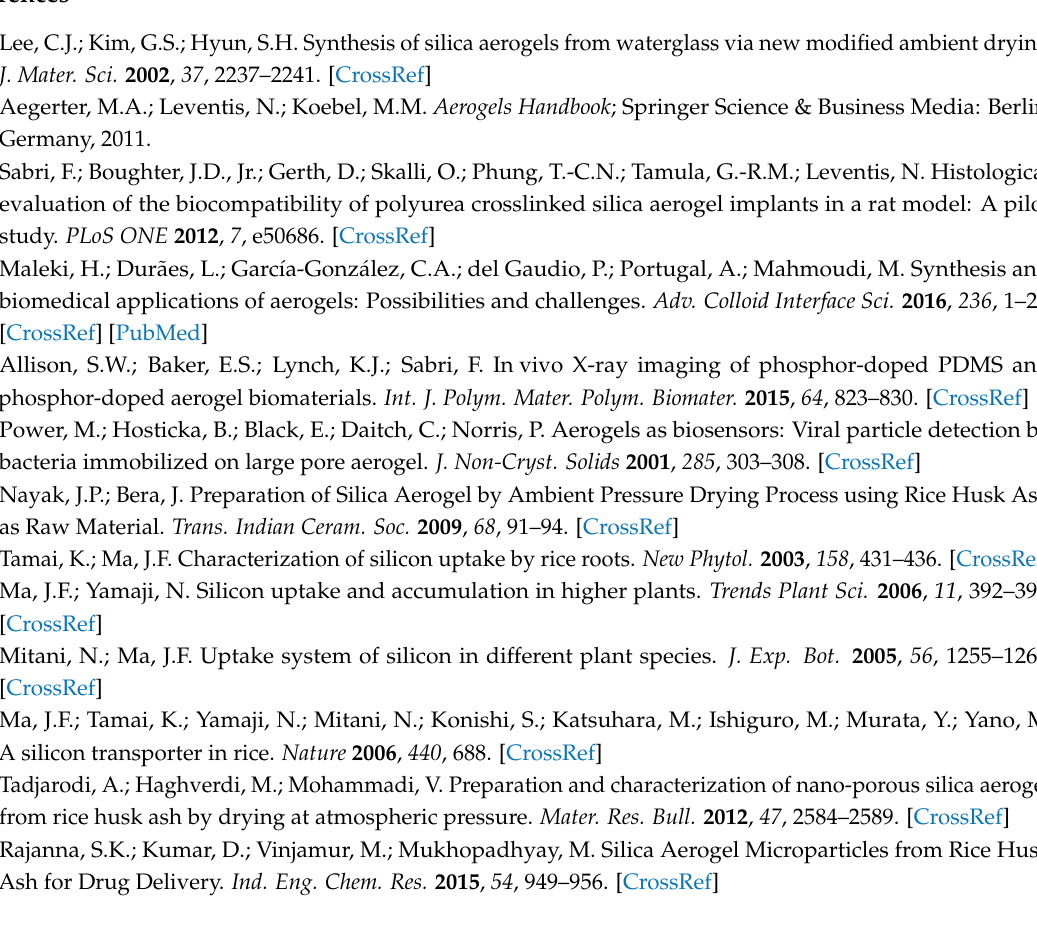
Figure S1: Nitrogen adsorption isotherms of the silica aerogels obtained at various values of pH, Figure S2: Pore size distributions of the silica aerogels prepared at various pH, Figure S3: Nitrogen adsorption isotherms of the silica aerogels synthesized using various acid feed rates, Figure S4: Pore size distributions of the silica aerogels obtained using various acid feed rates, Figure S5: FE-SEM images of the rice husk-based silica aerogel at the acidic feed rate of 0.5~5.0